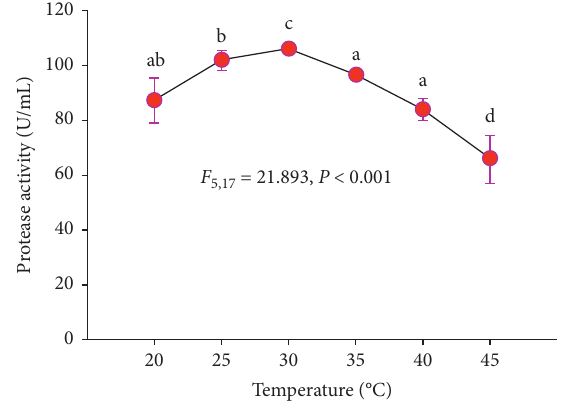
Figure 8: Effect of initial media pH on the production of acid protease from filamentous fungi Z1BL1 in SSF. Different letters (a, b, c, d, e) designate significantly different means as determined by SPSS test ( P < 0 . 001 ) ; wheat bran moistened with a salt solution; temperature 30 °